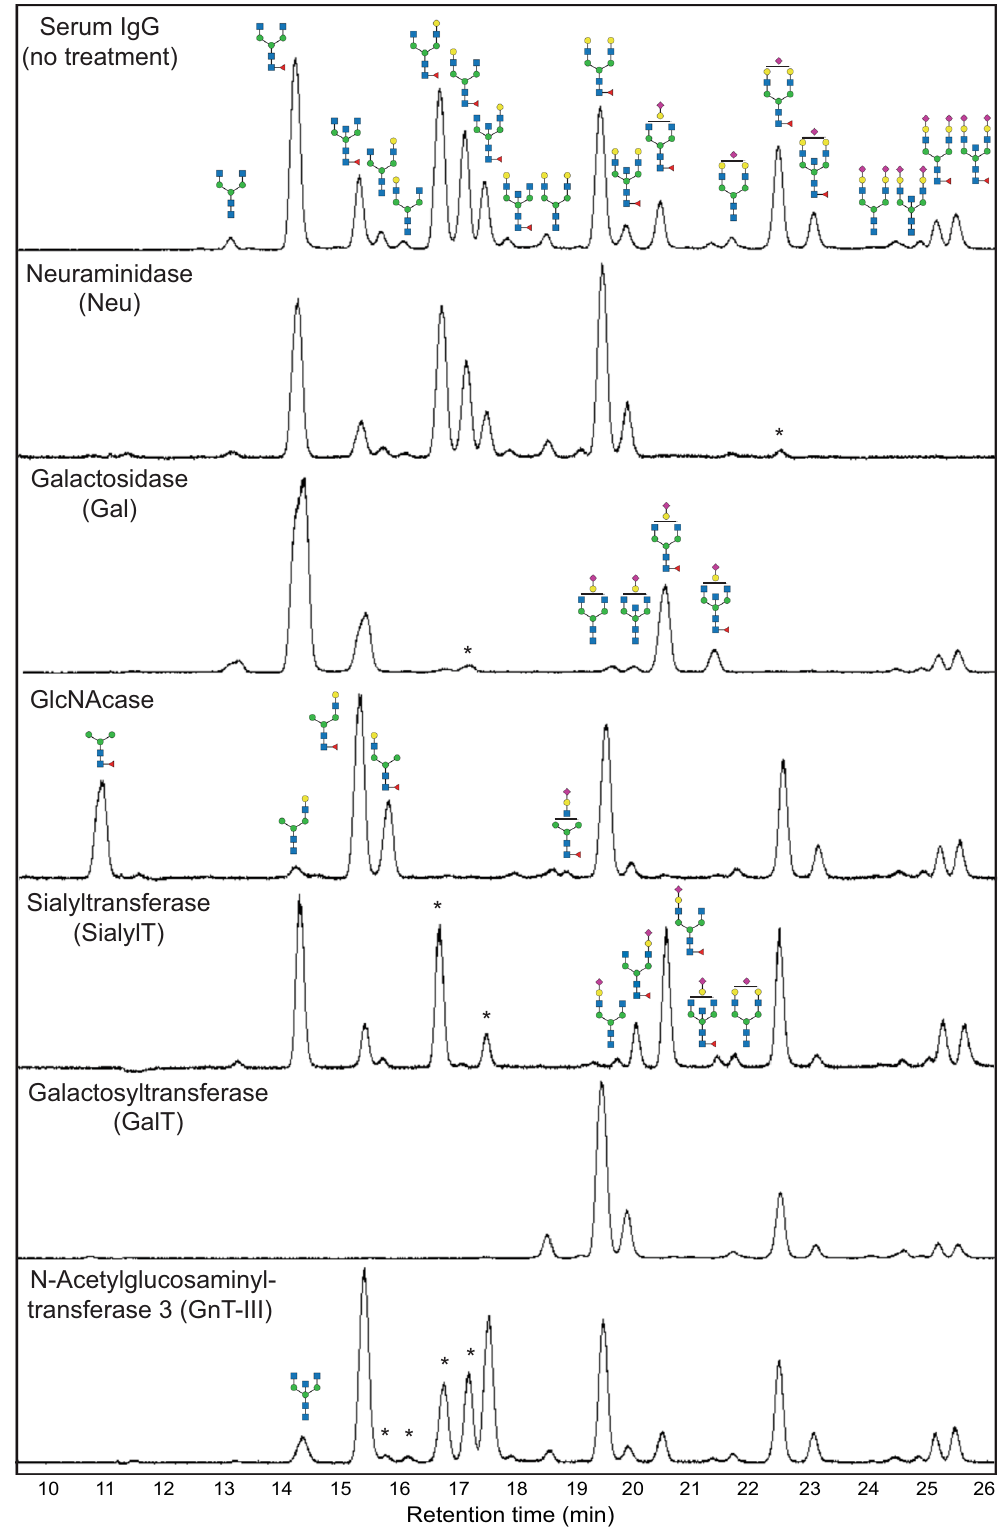
Fig. 2 Chromatogram of glycans collected from IgG treated with different glycoengineering enzymes. The data was collected from reactions that reached, or were close to, the plateau of the conversion. The formation of glycoforms was con fi rmed by mass spectrometry analyses. Please refer to Table S2 for detailed reaction conditions. Star marks indicated the substrate glycan species that have not been fully transformed in the